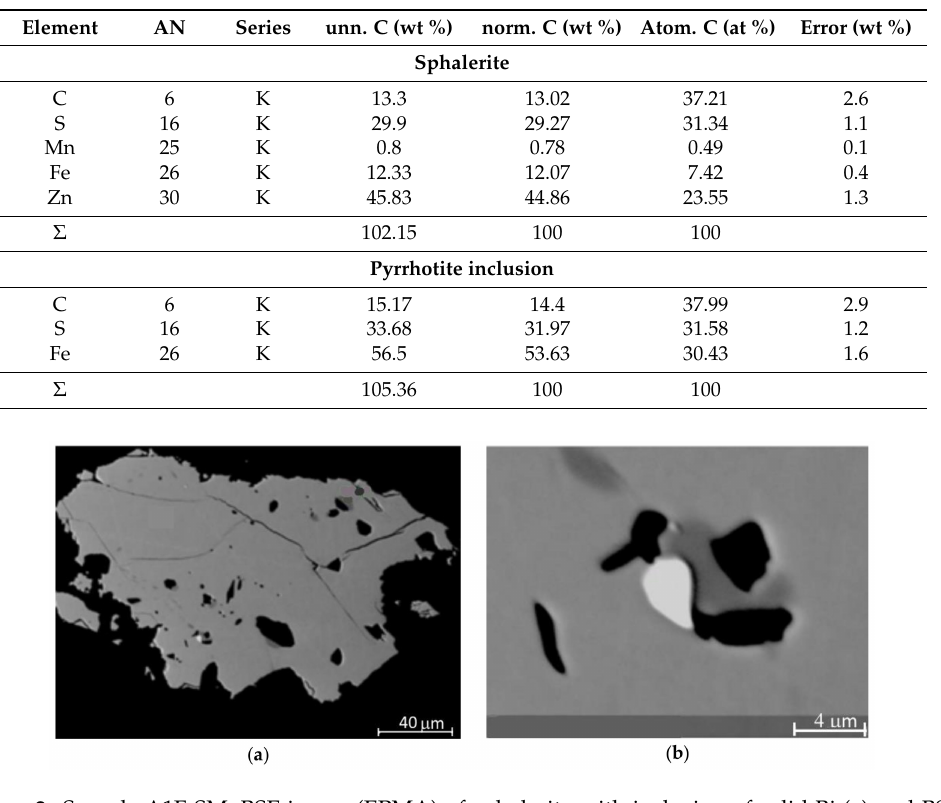
Figure 2. Sample A1F-SM: BSE image (EPMA) of sphalerite with inclusion of solid Bi ( a ) and BSE image (EPMA) of solid Bi inclusion surrounded by sphalerite and chalcopyrite ( b ).